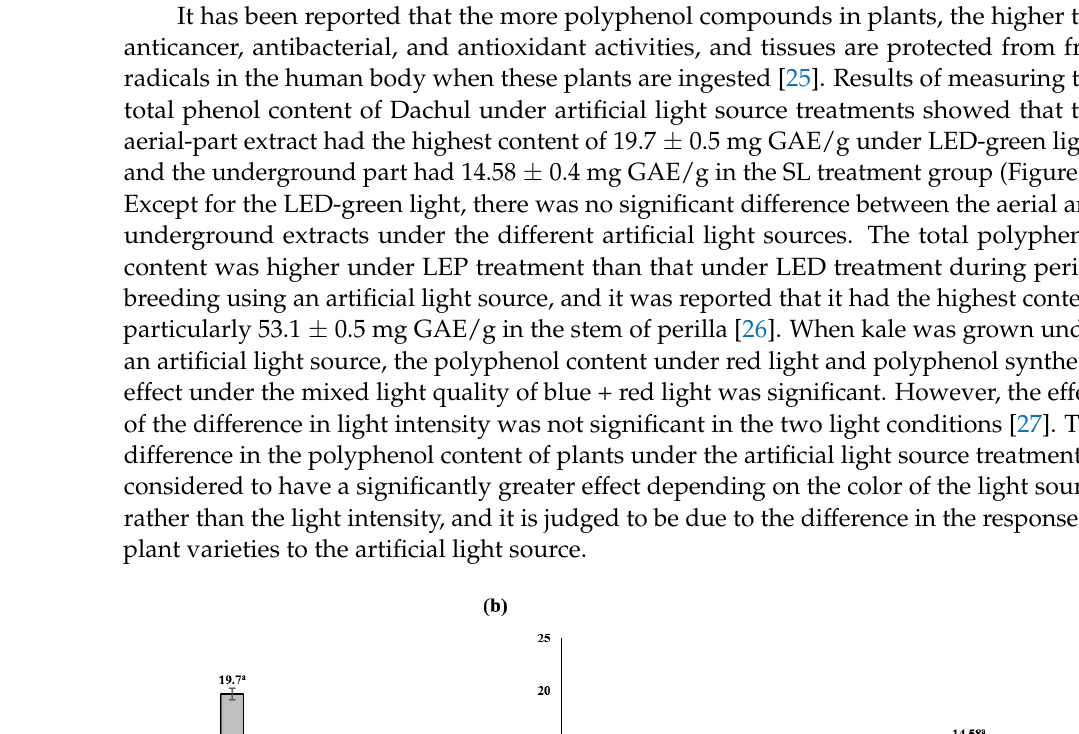
Figure 2. The inhibition rate of DPPH free radical scavenging activities of aerial ( a ) and under- ground ( b ) parts from extracts of Dachul under different light sources. Values represent mean of data obtained from three independent experiments ( p < 0.05).